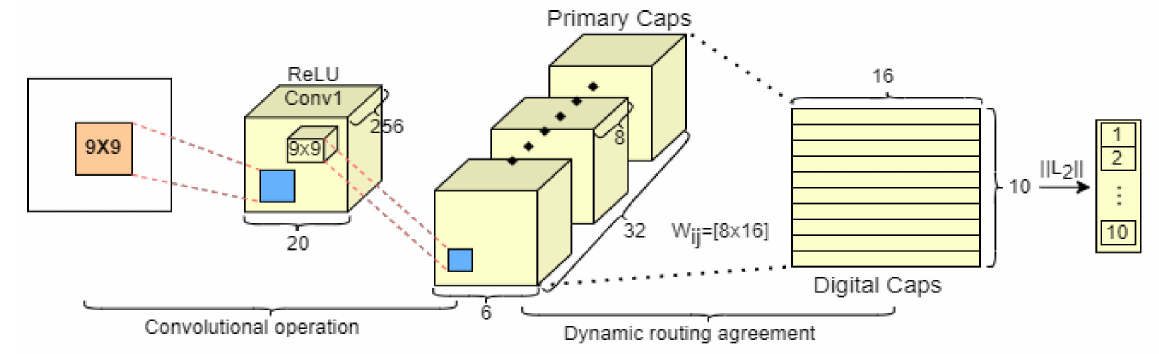
Figure 2. The basic architecture of